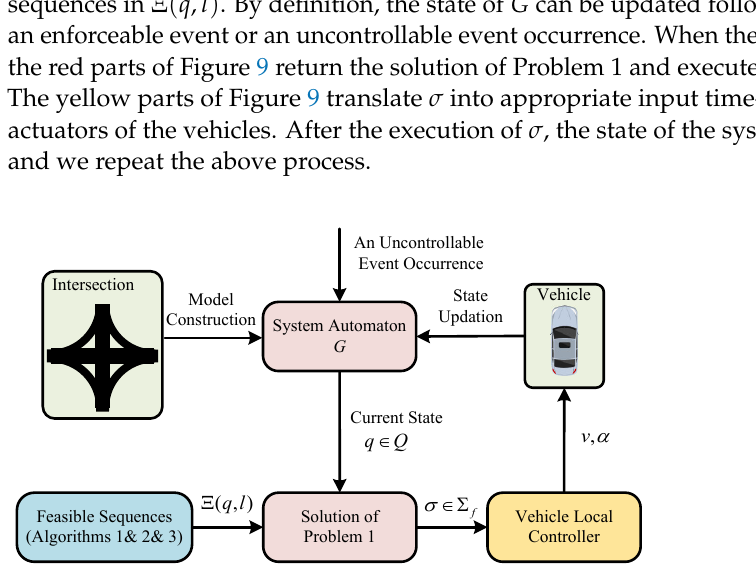
Figure 9. The structure of the traffic management